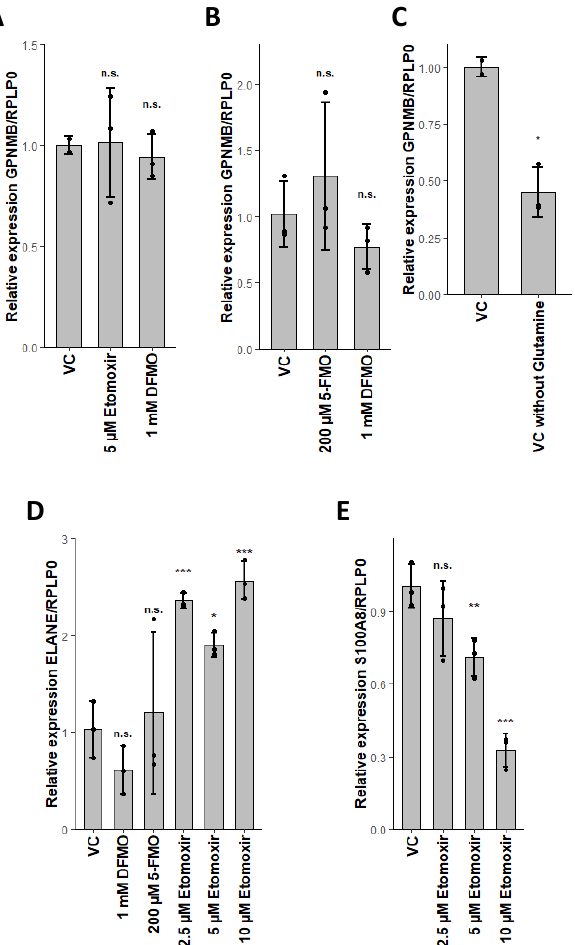
Figure 3. Glutaminolysis is essential during dendritic cell differentiation, while fatty acid oxidation is essential for neutrophil maturation. ( A ) Effect of etomoxir or difluormethyl-ornithine (DFMO) in the presence of glutamine on GPNMB/RPLP0 expression of dendritic cells. ( B ) Effect of 5-fluoromethylornithine (5-FMO) or DFMO in the absence of glutamine on GPNMB/RPLP0 expression of dendritic cells. ( C ) Effect of glutamine on GPNMB/RPLP0 expression of dendritic cells. ( D ) Effect of 5-FMO, DFMO or etomoxir in the presence of glutamine on ELANE/RPLP0 expression of neutrophils. ( E ) Effect of etomoxir in the presence of glutamine on S100A8/RPLP0 expression of neutrophils. Data are represented as mean ± SD ( n = 3). Relative gene expression was calculated as stated in the methods section. Significant changes were assessed by one-way ANOVA (n.s. not significant; * p < 0.05; ** p < 0.01; *** p < 0.001).